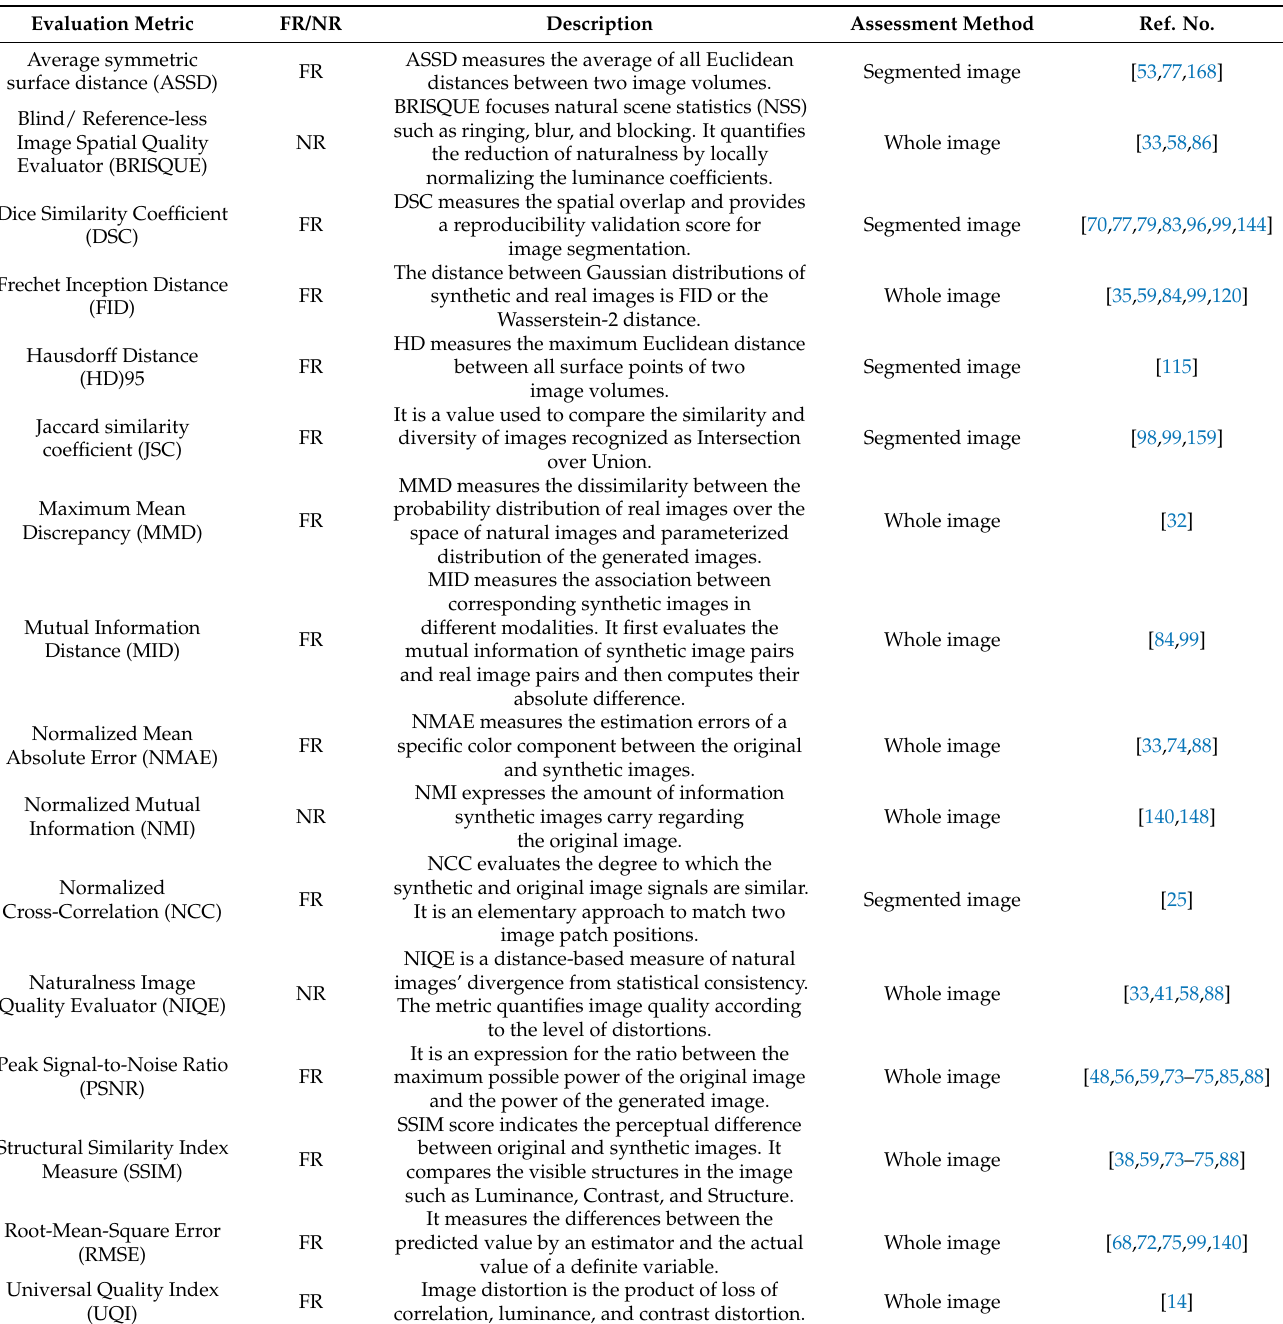
Table 10. Comparative study of evaluation metrics used in this